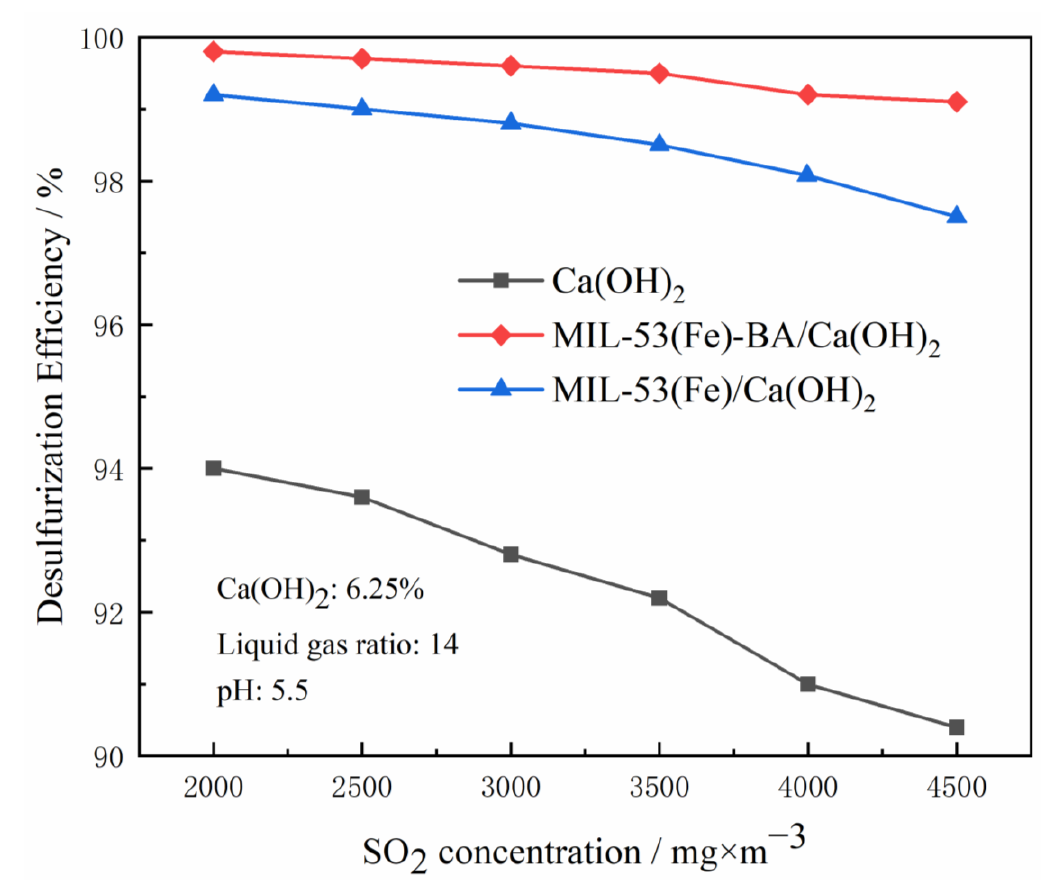
Figure 10. Effect of SO 2 concentrations on desulfurization efficiency.